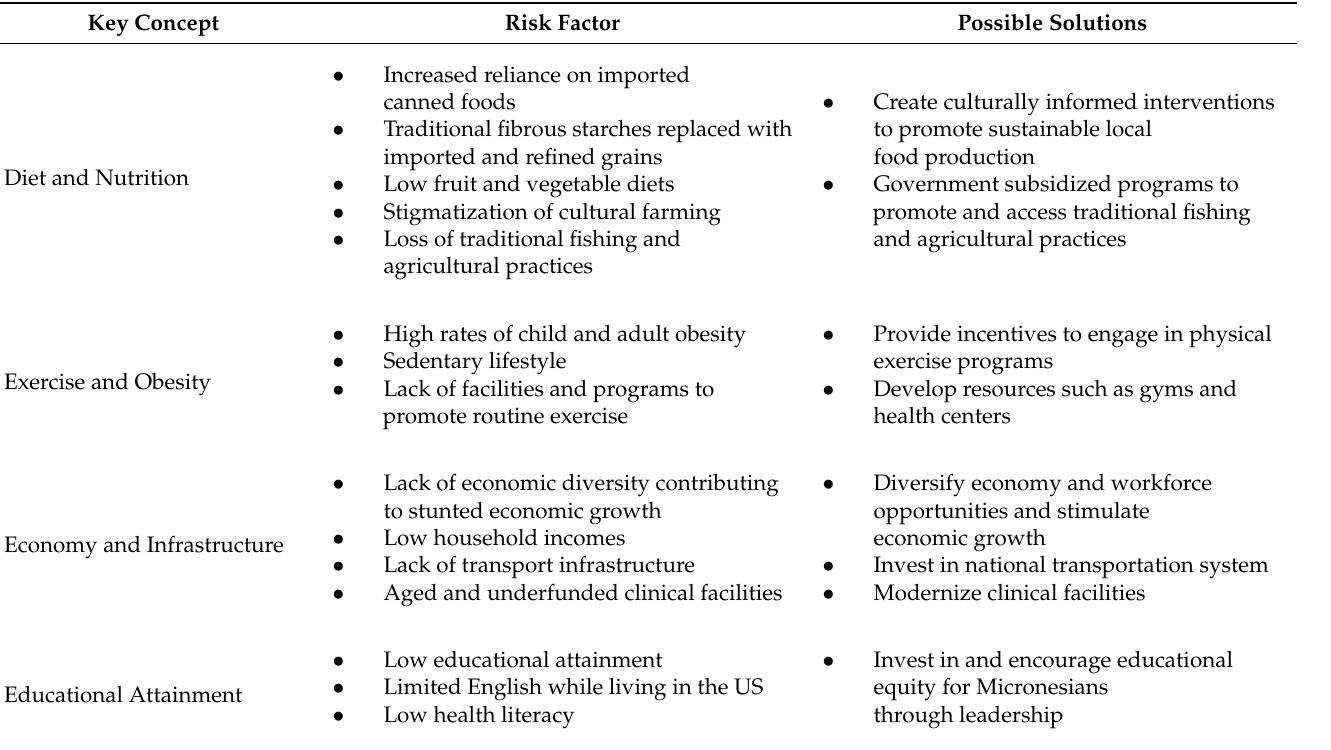
Table 2. Risk factors and possible solutions for diet and nutrition, exercise and obesity, economy and infrastructure, and educational attainment related to Micronesians with respect to